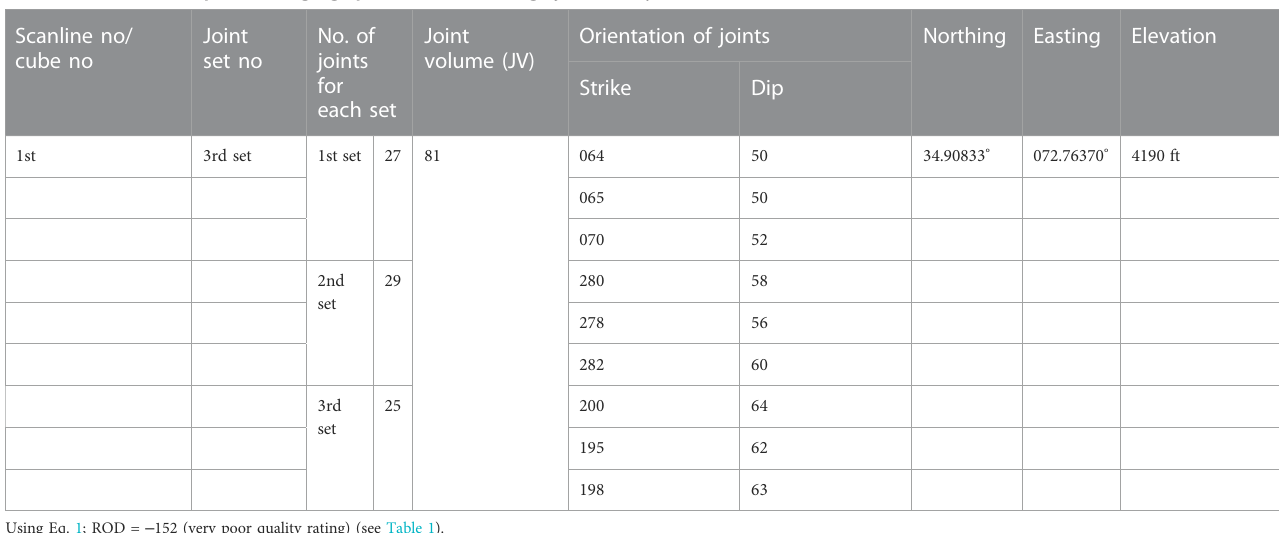
TABLE 2 JV, strike and dip data, and geographic coordinates of high joint density rocks.